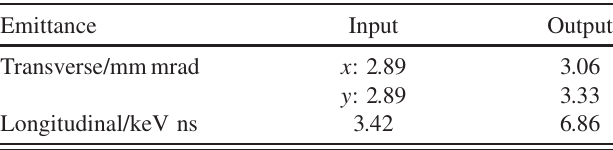
TABLE II. Normalized rms-emittance values for the input and output distribution of the laser generated case (216 mA).